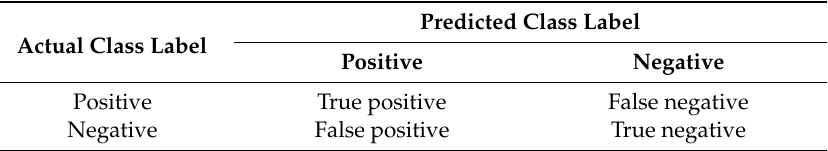
Table 4. Confusion